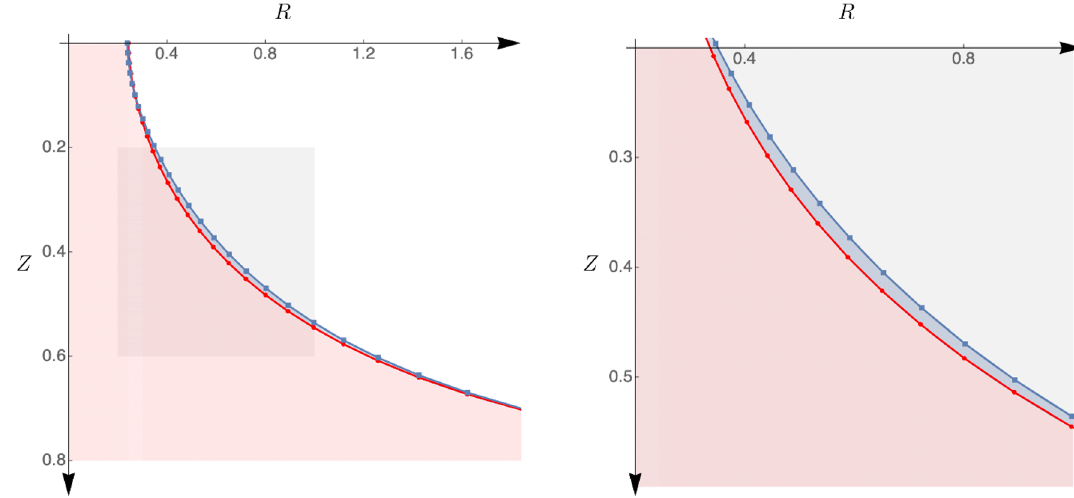
Figure 2 . Isometric embeddings of the spatial cross section of H + (red disks) and the ergosurface (blue squares). These curves were generated with T 1 =T BH = 2 : 5. The right panel shows a zoom of the shaded region on the left, so that one can more easily identify the ergoregion. The red shaded region corresponds to the interior of the black funnel, and the blue shaded region to the